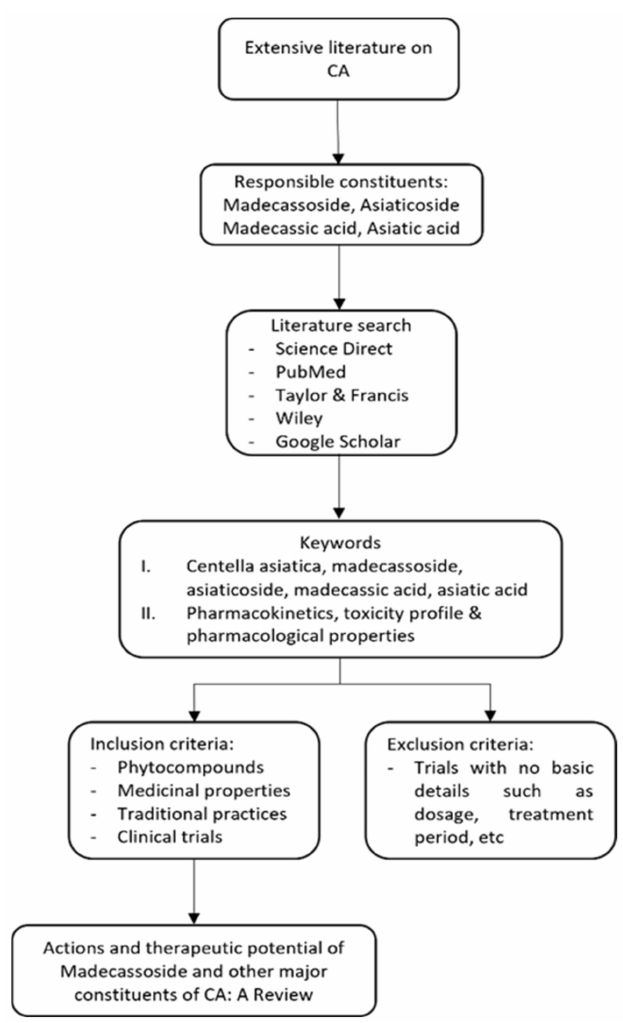
Figure 1. Summary of